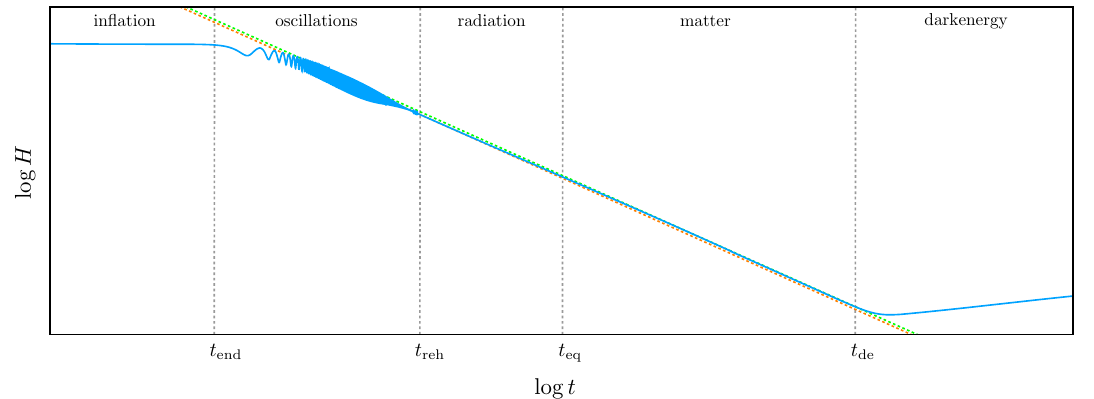
Fig. 1 A unified evolution of the universe from very early times until today.Weplotlog H vs.log t startingfromaninflationarystage,passing through a transitionary phase characterized by strong coherent oscilla- tions, followed by radiation and matter to finally end in a dark energy